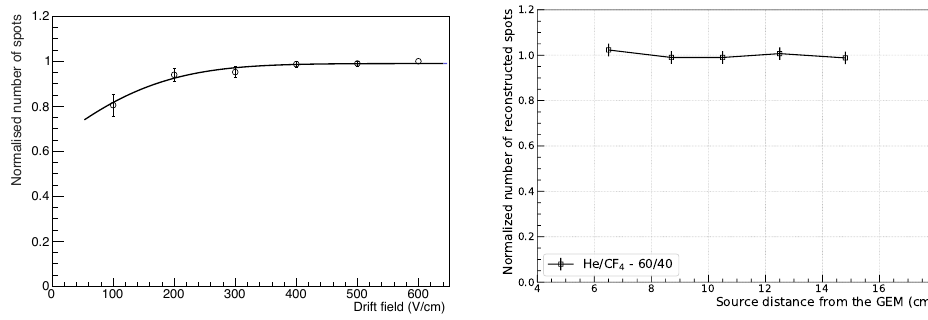
Figure 6. Behavior of the normalized number of 55 Fe spots as a function of the drift electric field ( left ) and event depth in the sensitive volume ( right ).